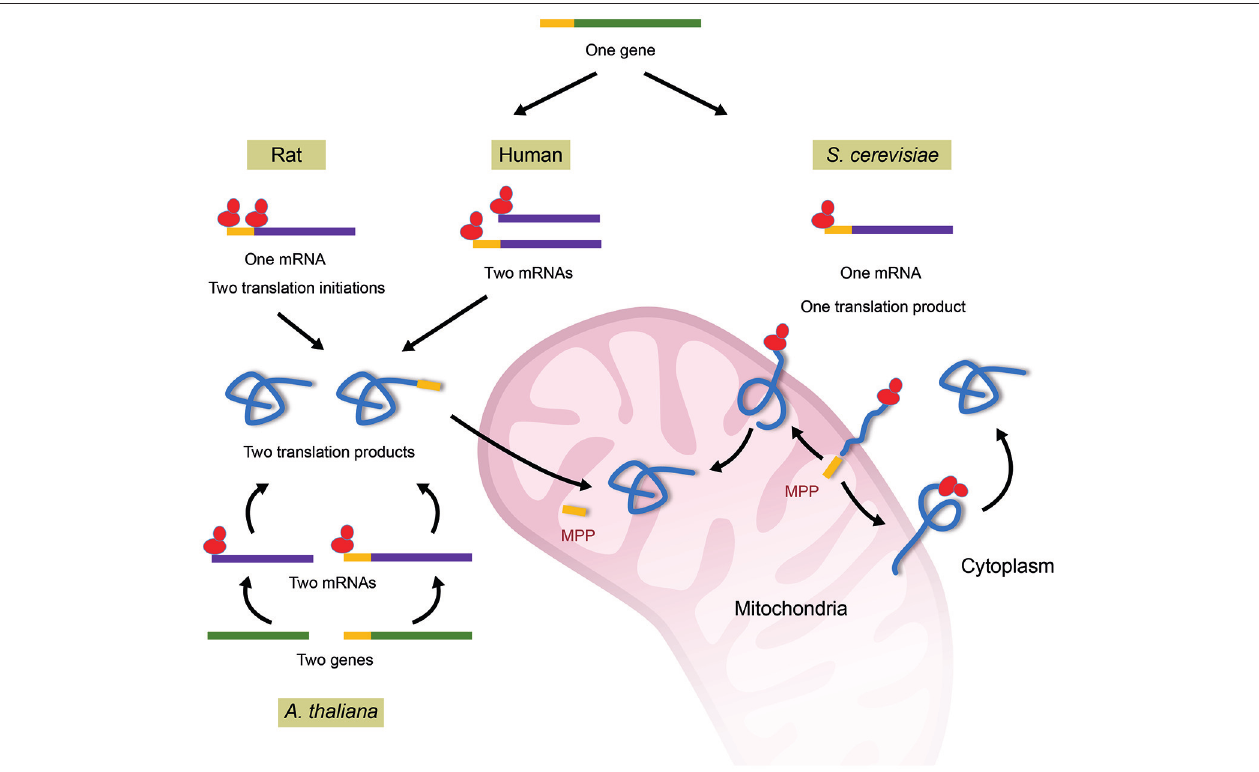
FIGURE 1 | Mechanisms of fumarase dual targeting in different organisms. In S. cerevisiae all fumarase molecules are first targeted to mitochondria, begin their translocation and are processed by the mitochondrial processing peptidase (MPP). Some of the molecules move back to the cytosol in a process termed “reverse translocation”; If folding of the fumarase protein molecule starts in mitochondria it will be localized to the mitochondrial matrix, however, if folding of the protein molecule starts outside mitochondria it will reside in the cytosol. In other words, the folding of fumarase is the driving force for its localization. In human , a single fumarase gene encodes two groups of mRNAs either encoding a full-length mitochondrial precursor that harbors an MTS, or a shorter cytoplasmic polypeptide that lacks it. In rat , a single fumarase gene encodes a single mRNA, which by differential translation initiation produces a full-length mitochondrial precursor that harbors an MTS and a shorter cytoplasmic polypeptide that lacks it. A. thaliana harbors two highly homologs fumarase genes that encode a mitochondrial or cytosolic protein, either containing or lacking an MTS respectively. Sequences encoding or indicating the mature fumarases are in green lines for DNA, purple for mRNA and light blue for protein. The MTS sequences are indicated by yellow lines and ribosomes colored